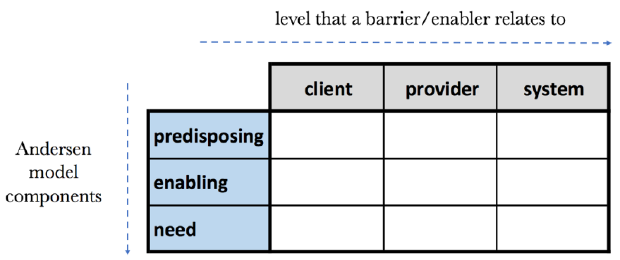
Figure 1. The health service utilisation matrix.